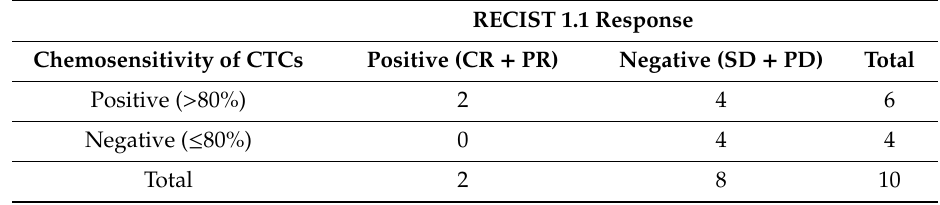
Table 4. Positive (complete or partial) and negative (stable disease or progression) RECIST 1.1 responses to 2-drug HAP, selected by liquid biopsy CTC chemosensitivity assay and associated with either > 80% (positive) or ≤ 80% (negative) CTC death, for both